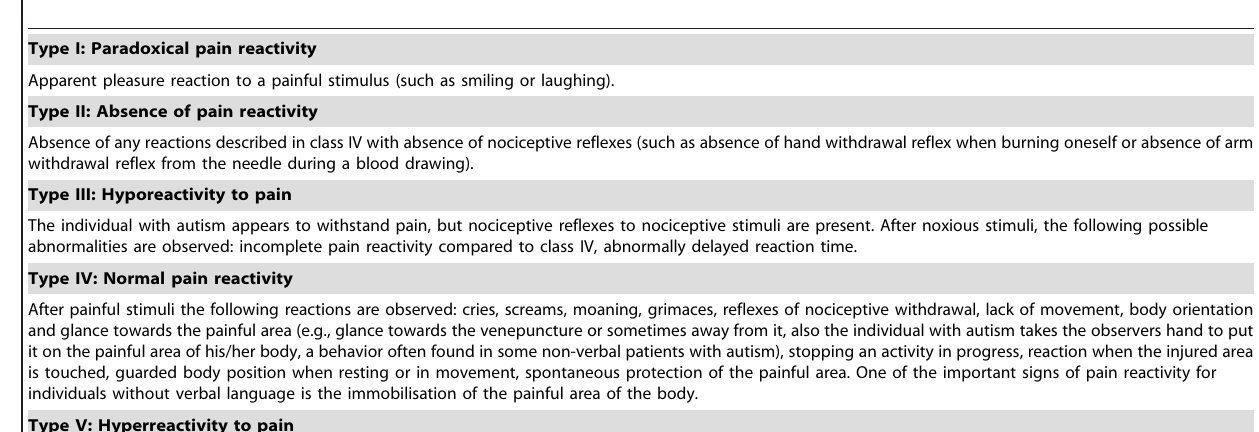
Table 3. Types of Pain Reactivity assessed by the PL-BPRS (Pre-Linguistic Behavioral Pain Reactivity